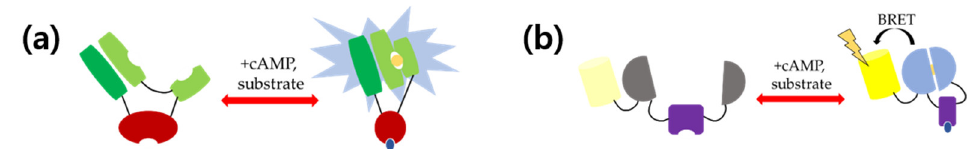
Figure 2. Schematic representation of structure and working mechanism of ( a ) single luciferase-based cAMP sensor 22F and ( b ) nano lantern-based cAMP sensor. Binding of cAMP initiates assemblage of firefly luciferase in 22F, leading to oxidation of substrate. In the nano-lantern-based cAMP sensor, binding of cAMP initiates assemblage of Renilla luciferase. Excitation by oxidation of substrate leads to energy transfer to Venus, resulting in yellow fluorescence emission.